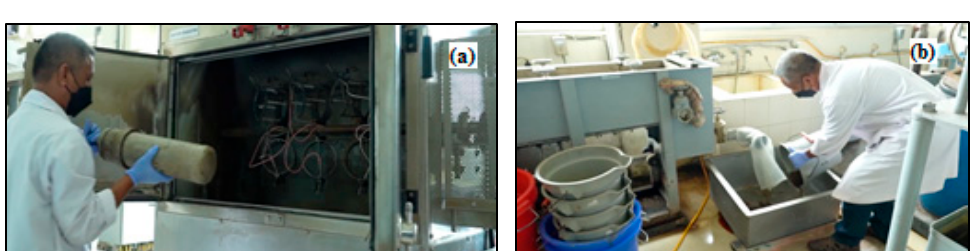
Figure 5. ( a ). The pulp from the first stage was put into the CRS AB rotary digester reactor with a capacity of 6 L and cooked at a temperature of 165 °C for 60 min. To reach the maximum temperature the pulp is held for 90 min, hence, the total time in the cooking process is 150 min; ( b ). The cooked pulp is then separated from the black liquor, washed and then screened to separate it from the